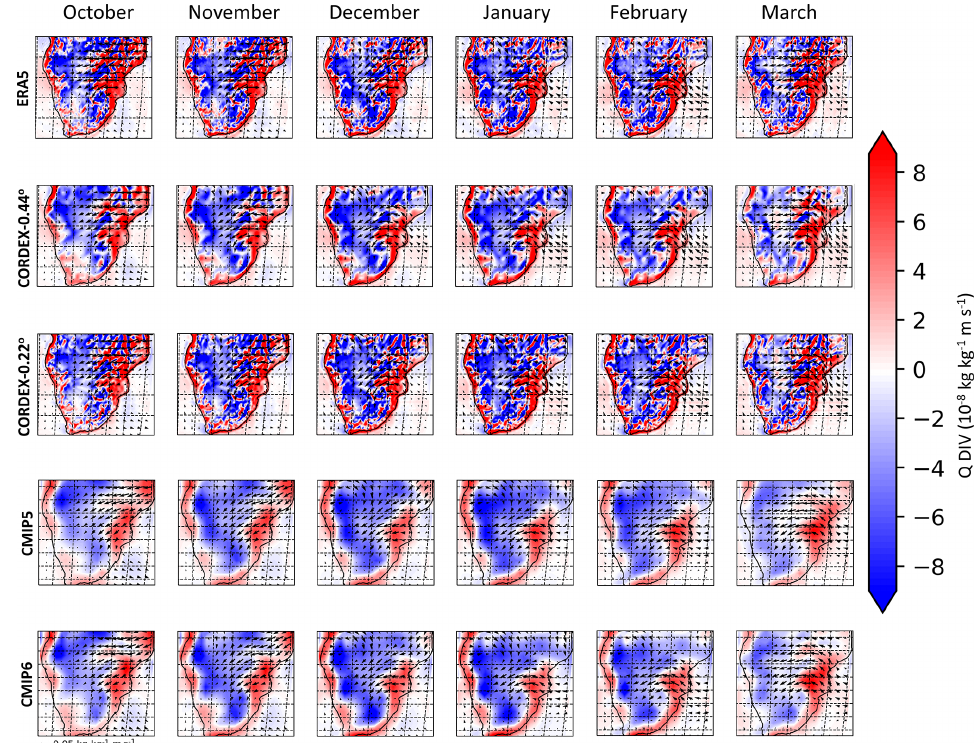
Figure 5. Mean monthly moisture flux and divergence at 850hPa during the period 1986–2005. Rows indicate the ensemble means analyzed. From top to bottom: ERA5, ensemble mean of CORDEX0.44 ◦ , CORDEX0.22 ◦ , CMIP5 and CMIP6